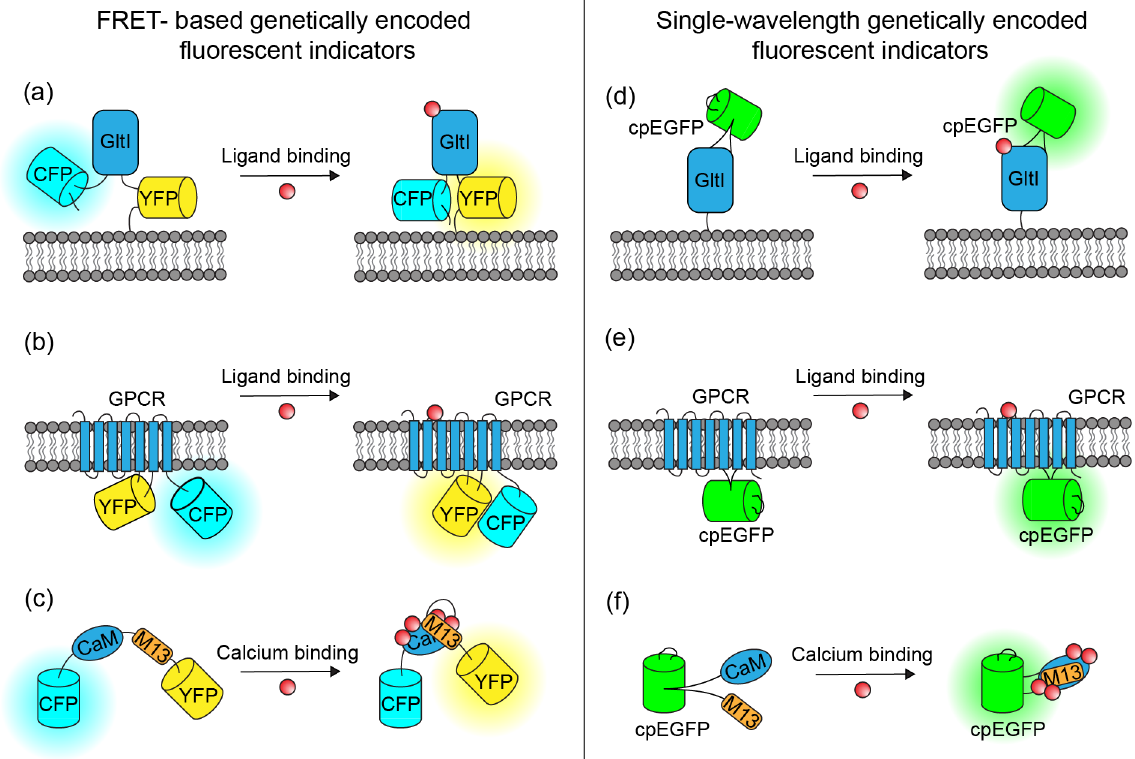
Figure 1. Multiple configurations of genetically encoded fluorescent indicators can image brain chemistry. ( a ) PBP/FRET- based genetically encoded neurotransmitter indicator (GluSnFRs). ( b ) GPCR/FRET-based genetically encoded neurotrans- mitter indicator (GPCR-cam). ( c ) FRET-based GECI (YC) ( d ) PBP/cpFP-based genetically encoded neurotransmitter indi- cator (iGluSnFRs). ( e ) GPCR/cpFP-based genetically encoded neurotransmitter indicator (dLight1). ( f ) cpFP-based GECI (GCaMP).